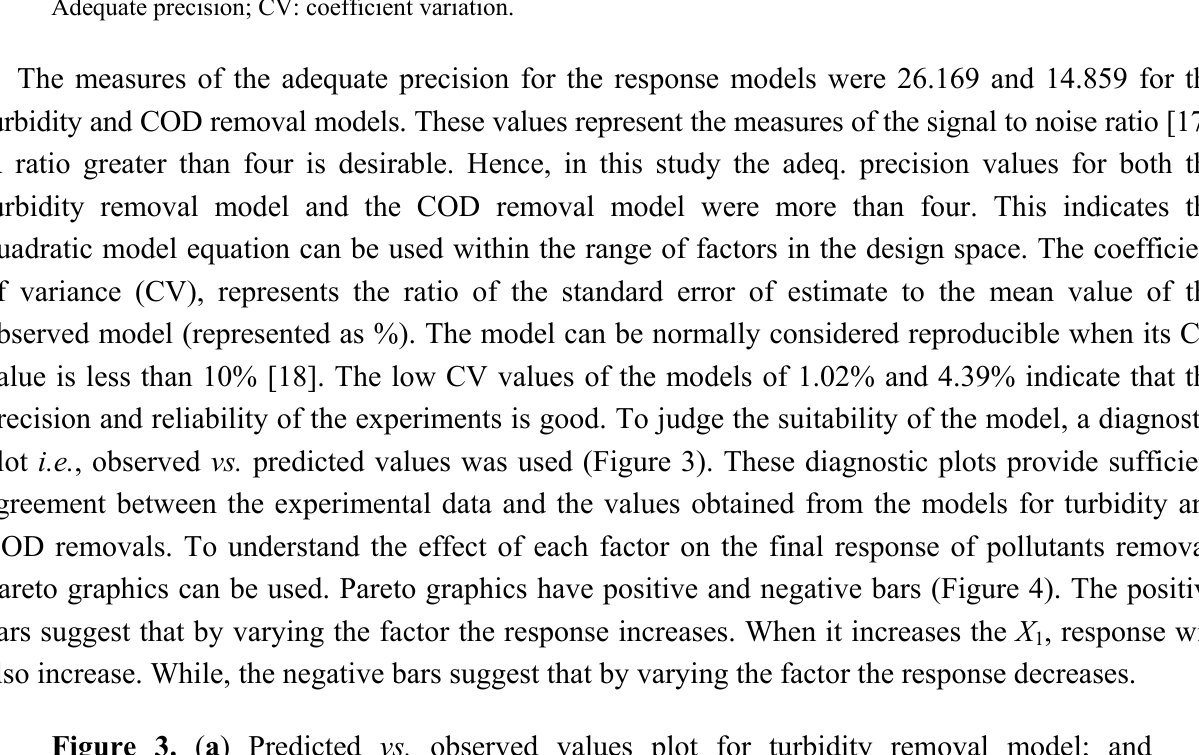
Figure 3. ( a ) Predicted vs. observed values plot for turbidity removal model; and ( b ) Predicted vs. observed values plot for COD removal